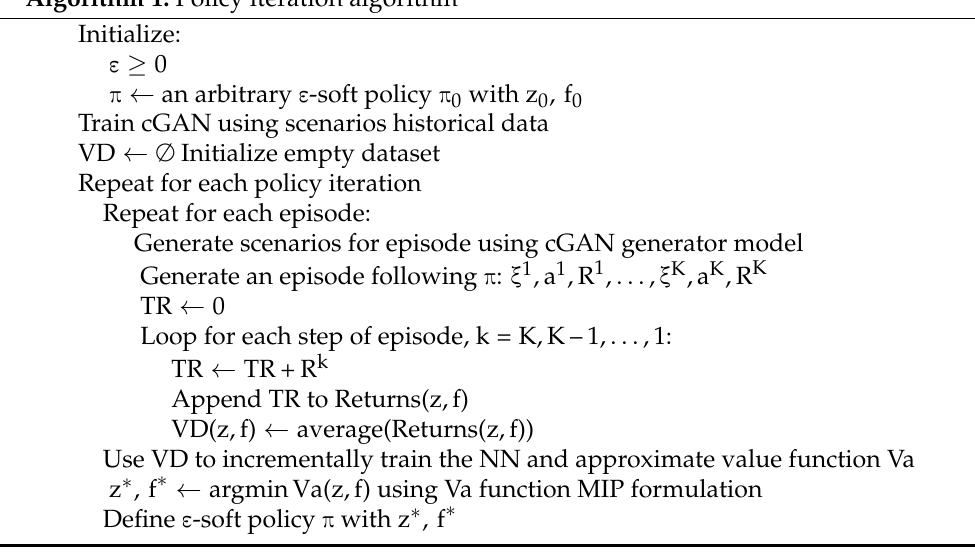
Algorithm 1: Policy iteration